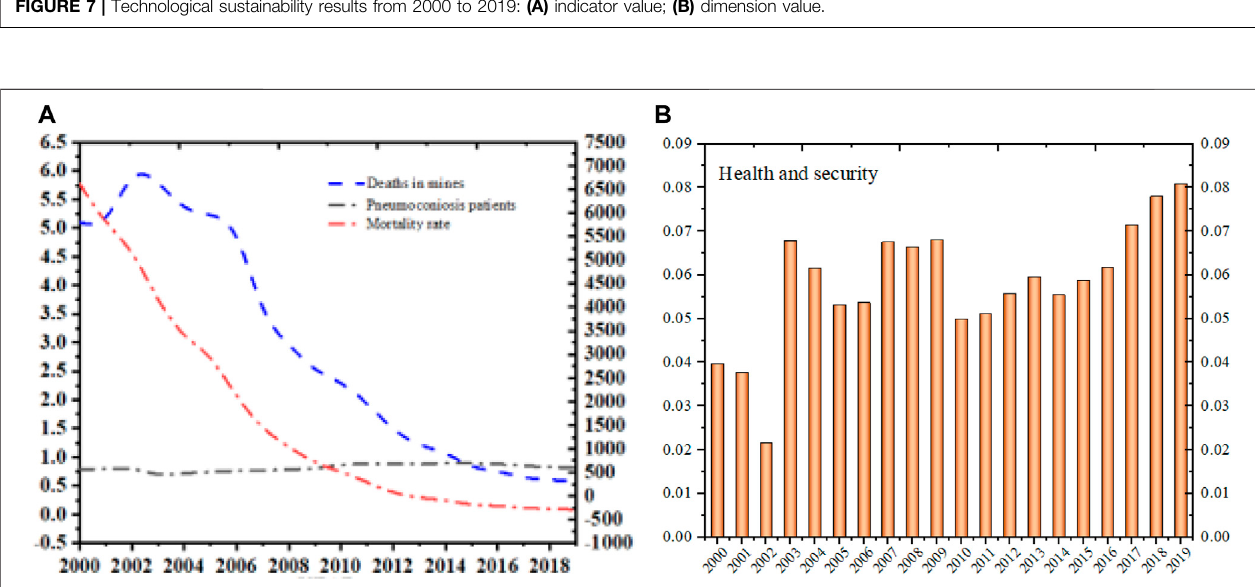
FIGURE 7 | Technological sustainability results from 2000 to 2019: (A) indicator value; (B) dimension value.